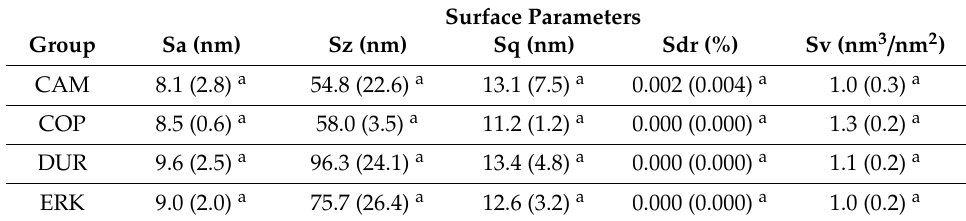
Table 2. Mean values and standard deviations (in parentheses) of five surface roughness parameters, namely average surface roughness (Sa), ten-point average roughness (Sz), root mean square surface roughness (Sq), developed surface area ratio (Sdr), and maximum pit height